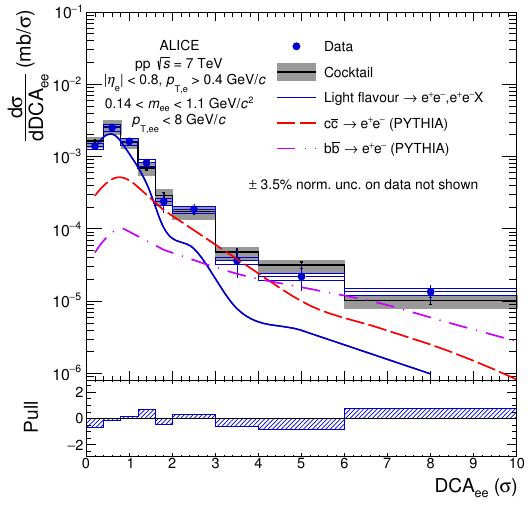
p s = 7 TeV in the